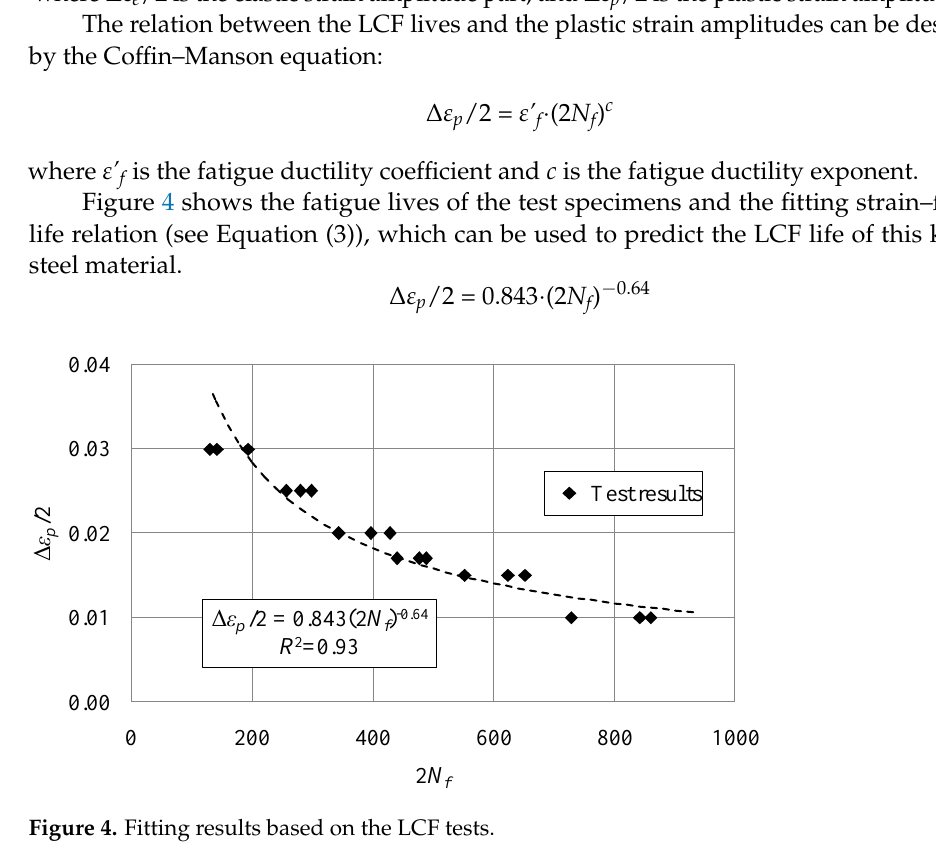
Figure 3. Hysteretic loops of low-cycle fatigue tests with strain amplitudes of: ( a ) 1.0%; ( b ) 1.5%; ( c ) 1.7%; ( d ) 2.0%; ( e ) 2.5%; ( f ) 3.0%.